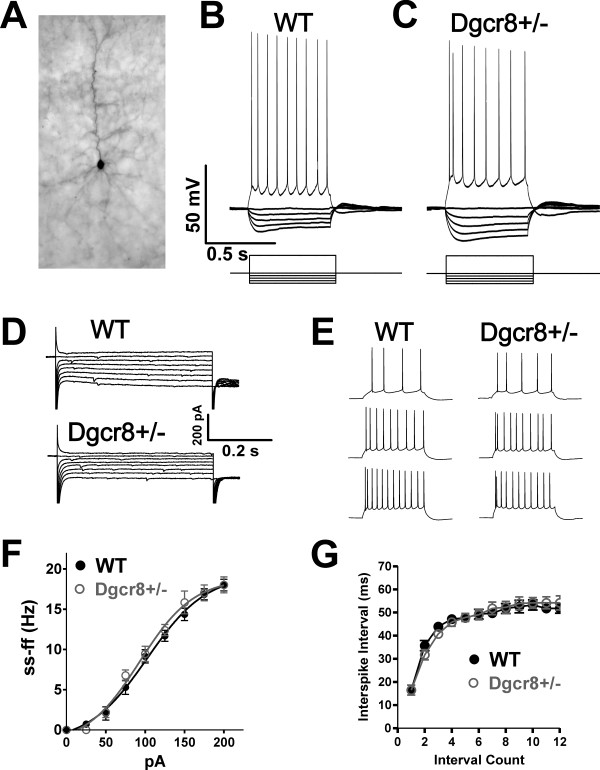
Altered electrical properties, but normal spike firing capabilities of pyramidal neurons in Dgcr8+/- mice. (A) Magnified image (20×) of a neurobiotin-labeled L5 mPFC pyramidal neuron filled during whole-cell recording. (B,C) Representative current-clamp recordings from mPFC L5 pyramidal neurons from (B) WT and (C) Dgcr8+/- mice show stereotyped pyramidal neuron firing patterns in both genotypes in response to a series of hyperpolarizing (-200 to -25 pA) and depolarizing (+100 pA) current injections. (D) I-V relationships were assessed in voltage-clamp mode through a series of 5-mV steps and demonstrate increased input resistance (Rin) in Dgcr8+/- neurons. (E) Action potential firing responses in WT and Dgcr8+/- neurons evoked by +75, +125 and +175 pA current injections. (F) The plot of the steady-state firing frequency (ss-ff) as a function of current intensity shows no changes in the input-output response between genotypes (WT n = 17; Dgcr8+/- n = 11). (G) Plot of the interspike interval between spikes of a train of action potentials evoked by +200 pA current injection demonstrates no changes in firing capabilities (WT n = 17; Dgcr8+/- n = 11).